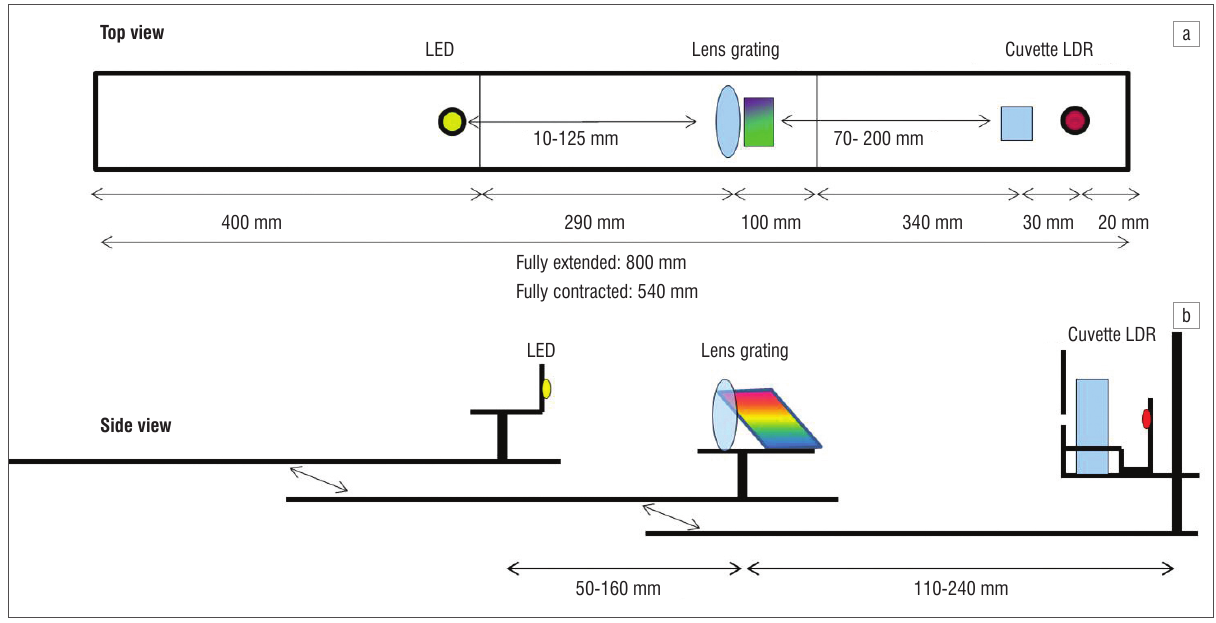
Figure 3: Schematic diagram of the (a) overhead view and (b) side view of the